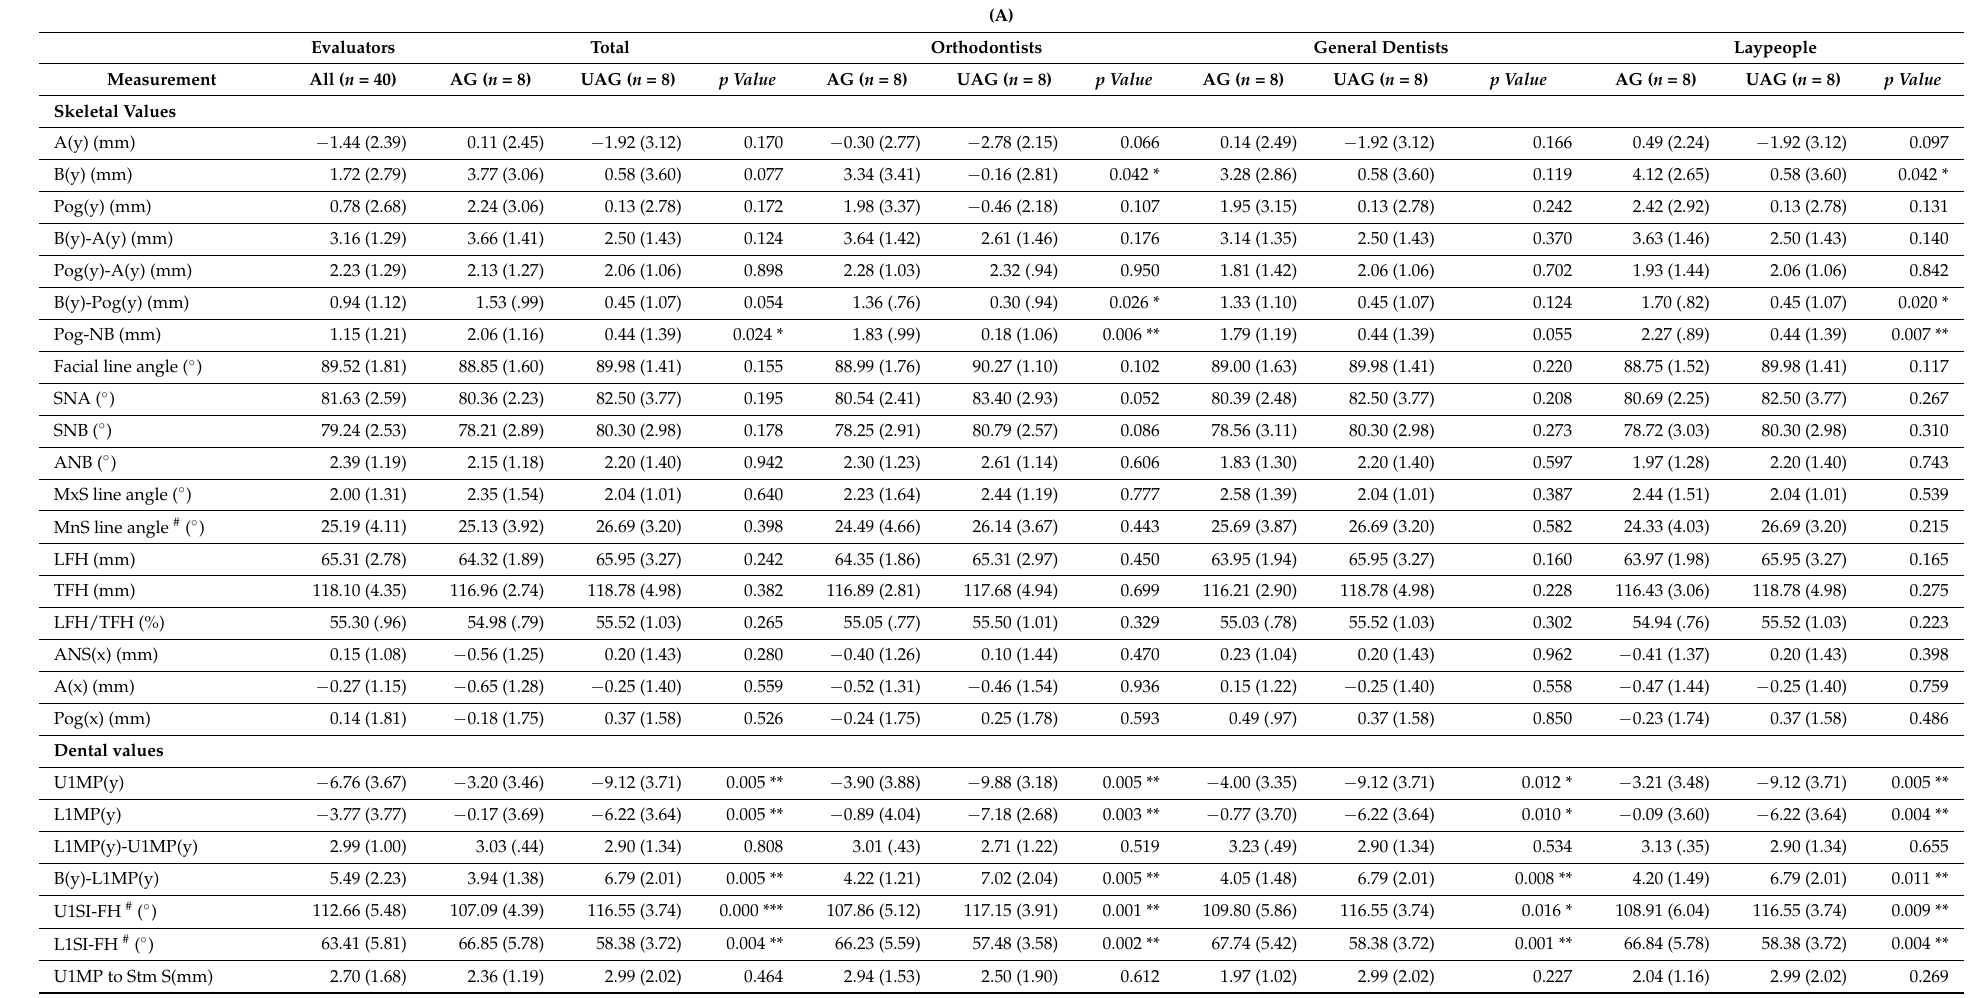
Table 2. ( A ) Comparison of three-dimensional measurements of skeletal and dental values between the attractive group (AG) and the unattractive group (UAG), according to perceived facial attractiveness in total and for each group of evaluators. ( B ) Comparison of three-dimensional measurements of soft tissue values between the attractive group (AG) and the unattractive group (UAG) according to perceived facial attractiveness in total and for each group of